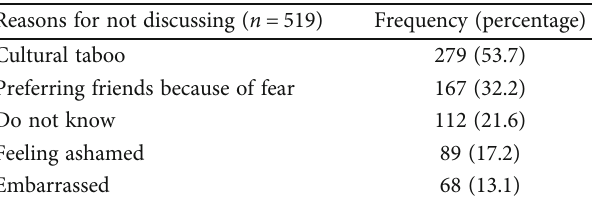
Table 2: Reasons mentioned by adolescent for not discussing SRH matters with their parents, Jimma Zone, Southwest Ethiopia,